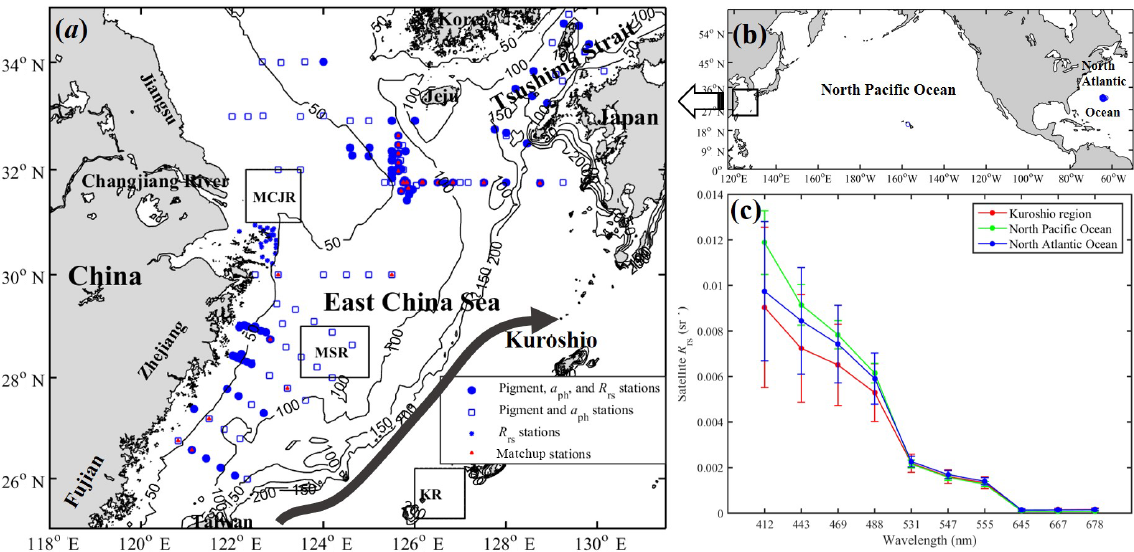
Figure 1. Distribution of in situ and matchup datasets and locations of the selected subareas (black boxes) (a) , namely MCJR (mouth area of the Changjiang River), MSR (middle shelf region), and KR (Kuroshio region); locations of sampling stations collected in the North Pacific and North Atlantic oceans from the NASA SeaBASS archive (b) ; the average satellite R rs (λ) spectra from 2003 to 2016 in the Kuroshio region, North Pacific Ocean, and North Atlantic Ocean (blue circles in b ) (c) . Error bars represent standard deviations of the